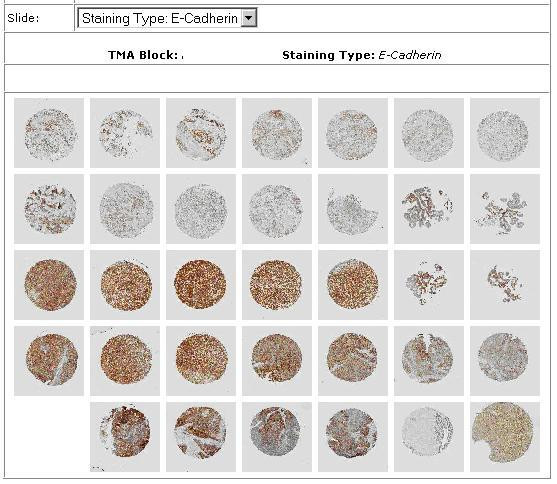
Overview of digital TMA slide as presented in the VTM interface. Clicking on any spot will result in an enlarged version of the spot being provided, as in Figure 5.